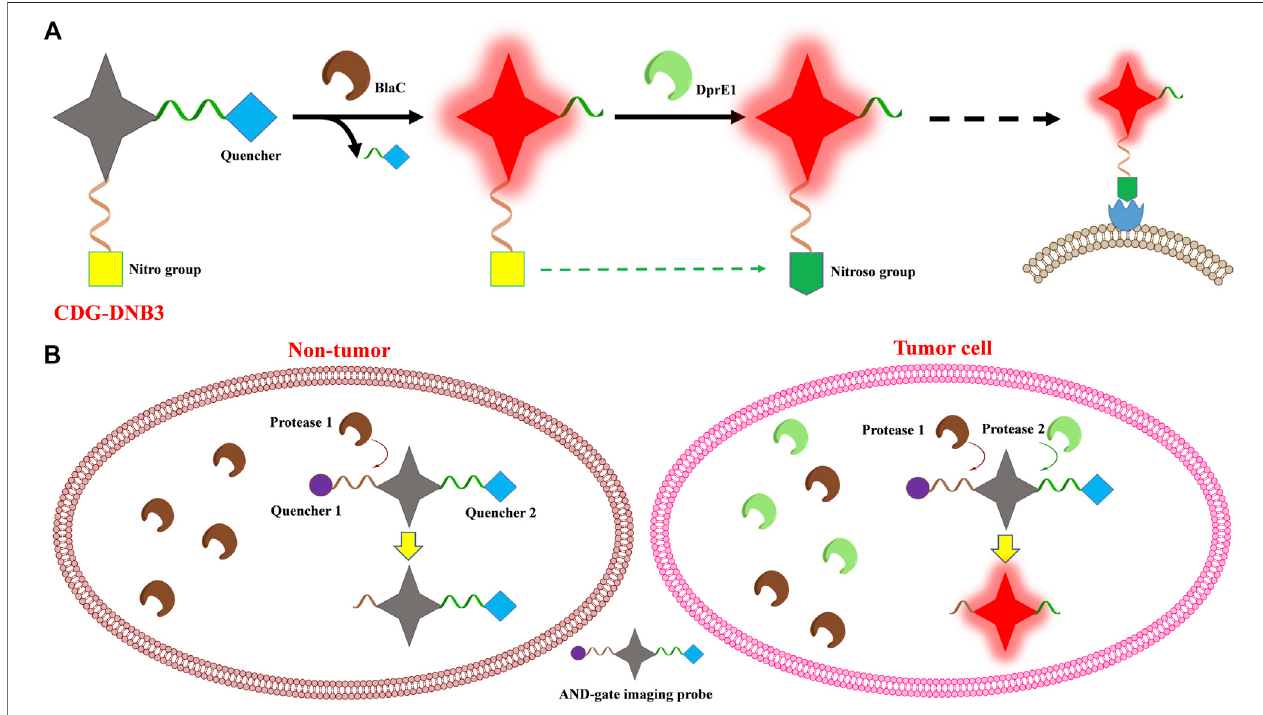
FIGURE 3 | Scheme of the multi-enzyme-activated probe design strategy. (A) CDG-DNB3 and (B) AND-gate imaging probe.